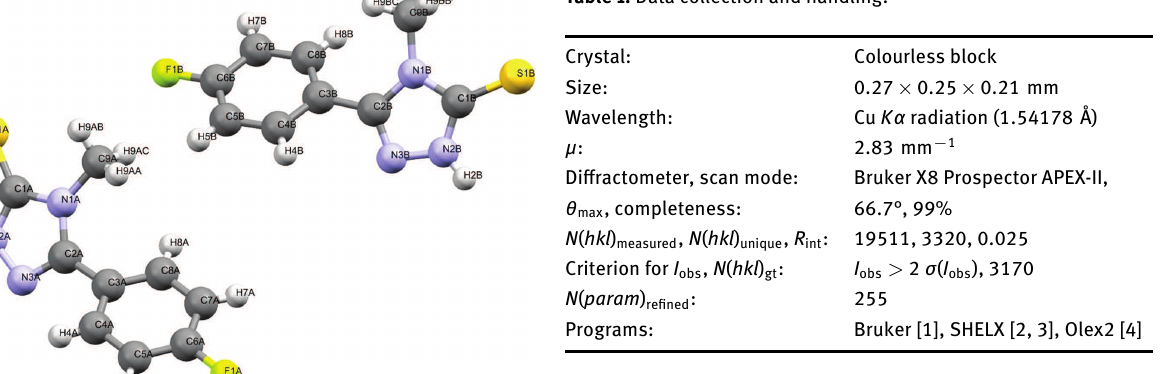
Table 1: Data collection and